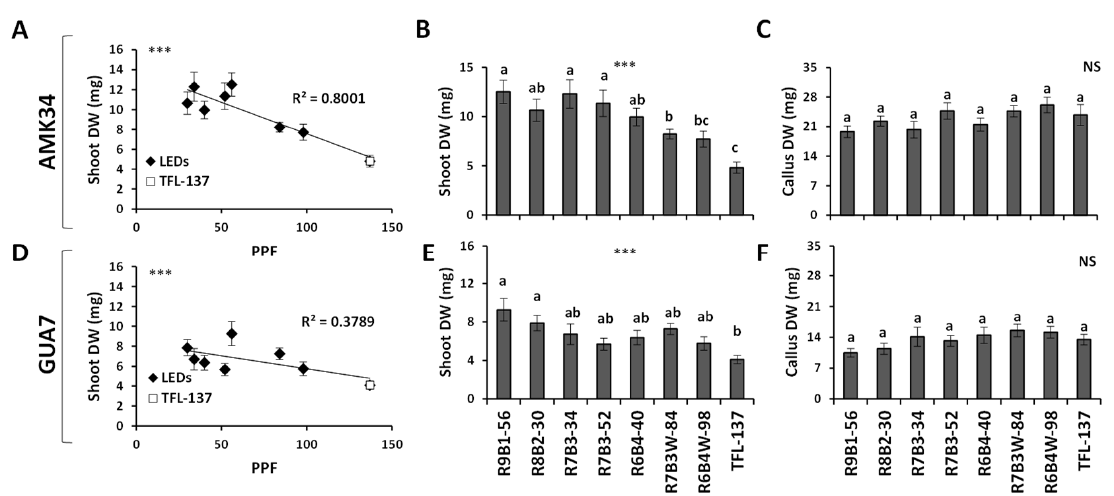
Figure 3. Effect of illumination quality and quantity on plant biomass. Correlation of light intensity with shoot dry weight (DW) in the olive genotypes AMK34 ( A ) and GUA7 ( D ). Effects of different illumination regimes from light-emitting diodes (LEDs) and fluorescent lighting (TFL-137) on shoot DW ( B , E ) and callus DW ( C , F ) of the olive genotypes AMK34 and GUA7, respectively. PPF, photosynthetic photon flux. Levels of significance: *** p ≤ 0.001; and non-significant (NS).